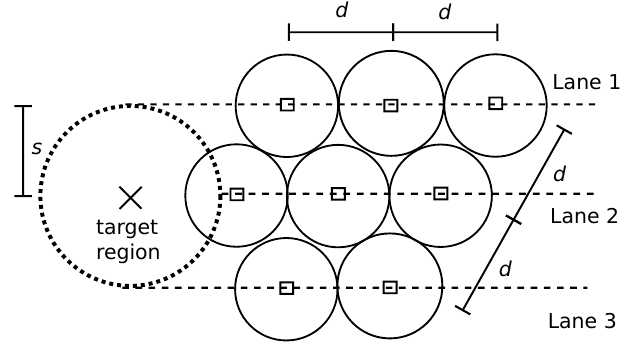
Figure 5. Robot lanes for hexagonal